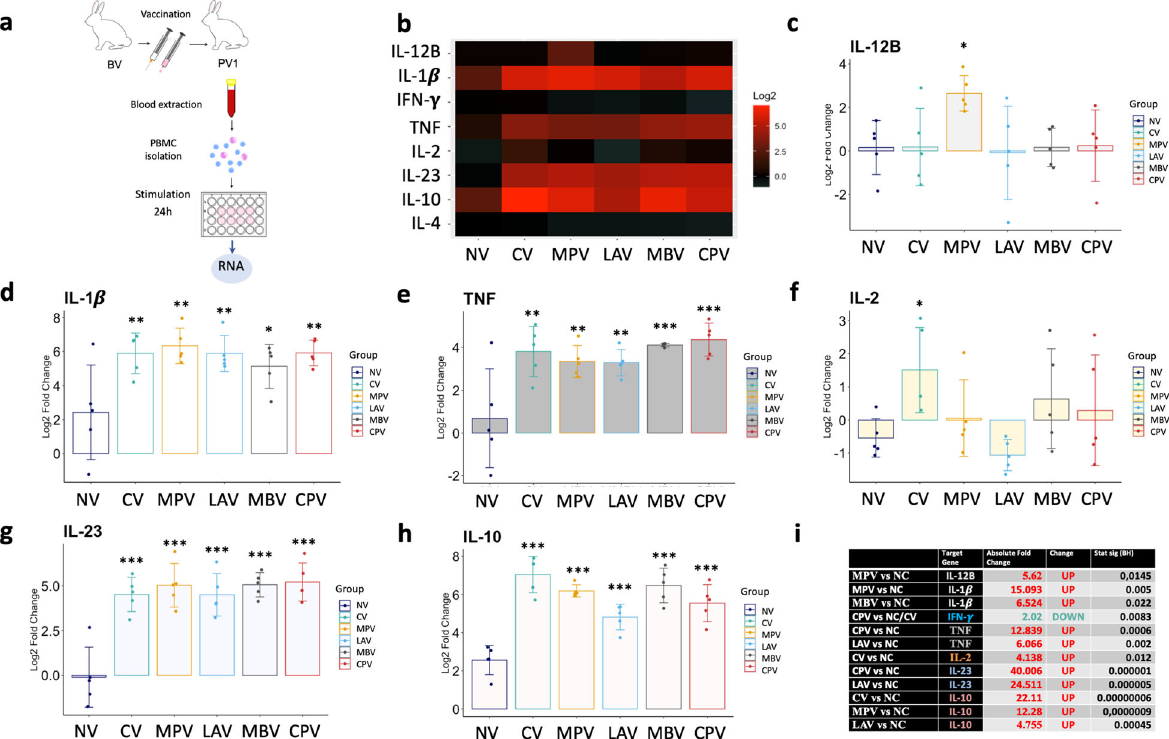
Fig. 7 Cytokine relative quanti fi cation by RT-qPCR of PBMCs isolated from animals at PV1, after ex vivo stimulation with Map sonicate (SM), of the studied vaccination groups relative to their correspondent non-stimulated control (PBS). a Schematic representation of sample origin. b Heatmap representation of the average expression of cytokines; in red upregulated and in green downregulated expression. Bar charts showing log2 fold change between groups. c IL-12B, d IL-1 β , e TNF, f IL-2, g IL-23A, h IL-10. i Table summarizing signi fi cant differences between groups in cytokine expression and the Absolute Fold Change Factor. For IL-1 β , TNF, IL-23A, and IL-10 only the higher and the lower Absolute Fold Change and p -values are detailed. All values were means with error bars representing standard deviation from groups of n = 5, except for NC which was n = 4. ANOVA with pooled SD with Benjamini & Hochberg correction was applied and signi fi cation levels are * p < 0.05, ** p < 0.01, ***<